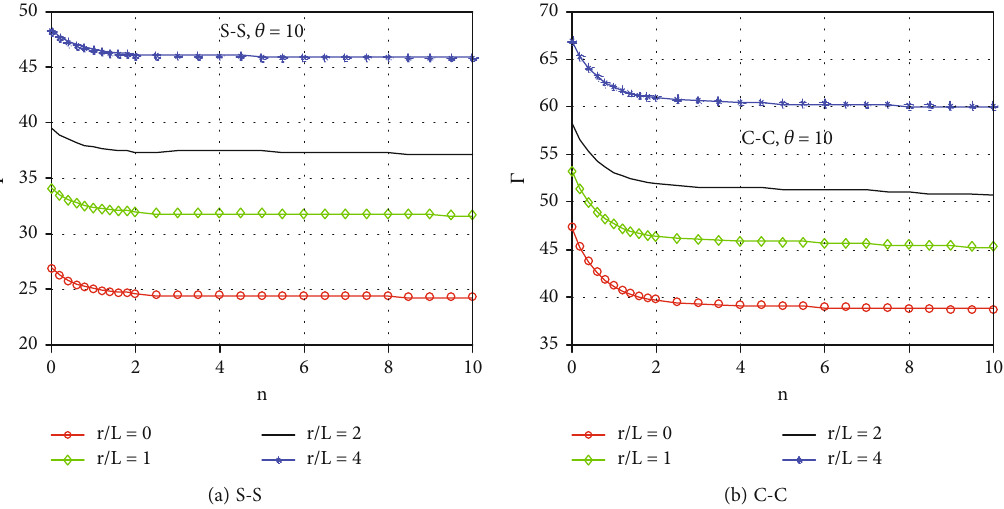
Figure 6: The subordination of the fi rst fundamental frequency of the piezoelectric FG beam on the ratio r / L and n ( θ = 10 ).